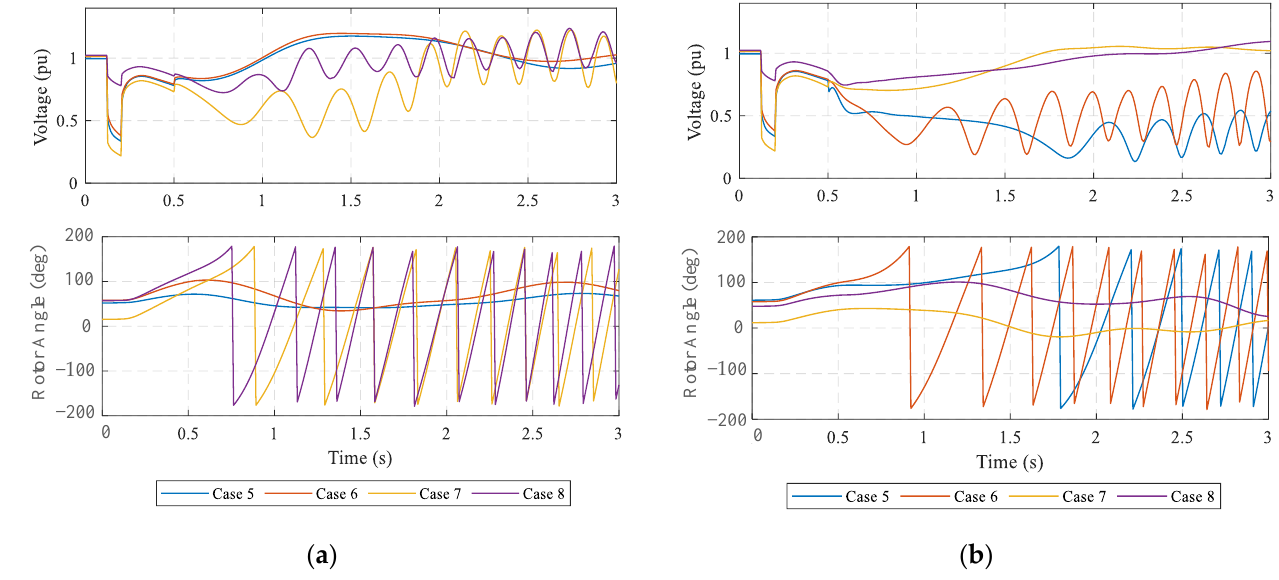
Figure 6. 𝑈 and 𝛿 responses after the application of emergency control actions: ( a ) motor load shedding; ( b ) generation tripping.